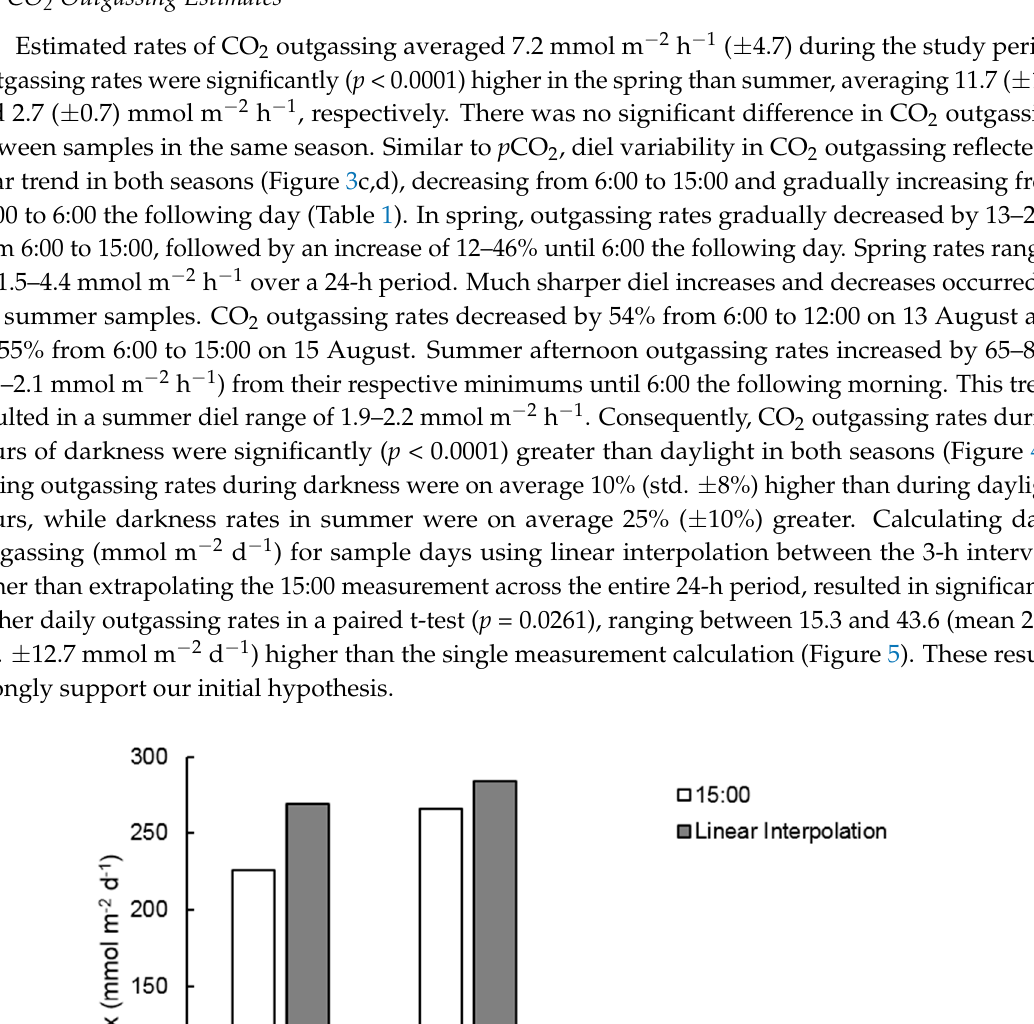
Figure 4. Mean p CO 2 ( a ) and CO 2 ( b ) outgassing rates during darkness and daylight hours by season. Bar pairs with different letters above them represent a significant difference between populations at α = 0.05. Error bars represent standard deviations.